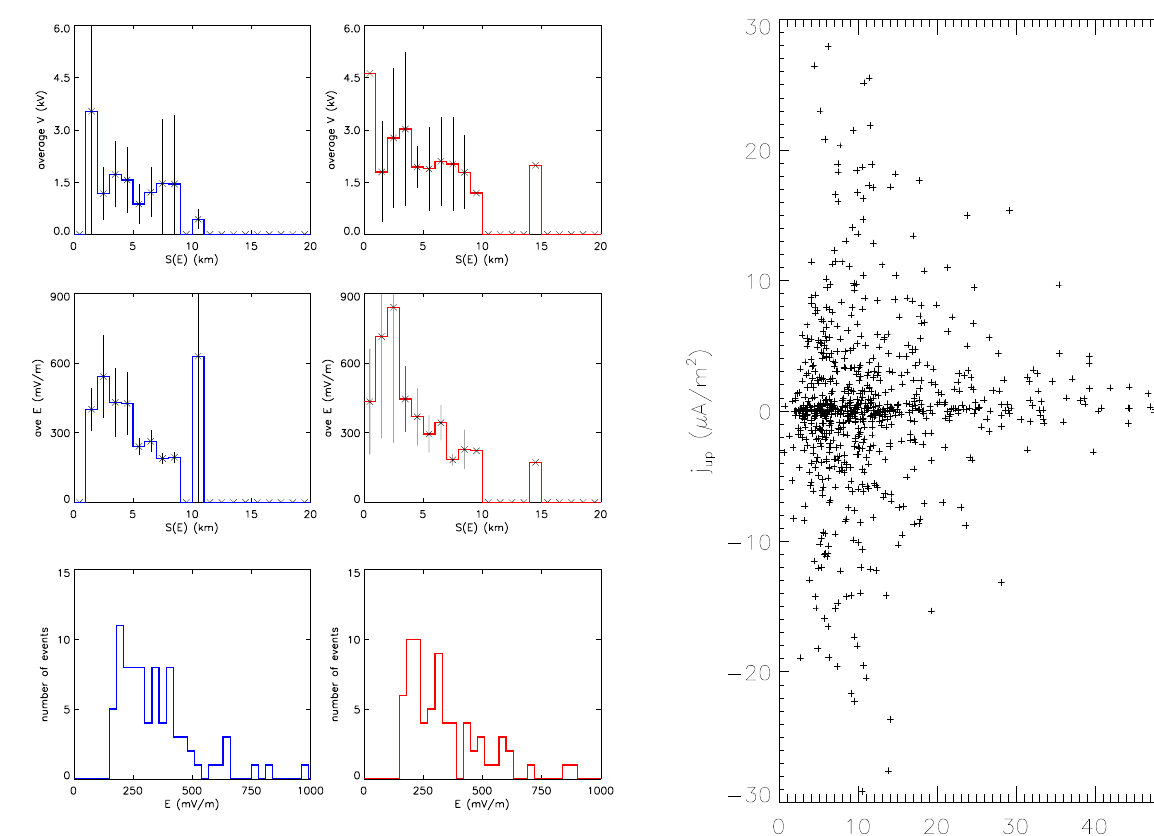
Fig. 7. Same as Figure 6, but this time only converging (red) and diverging (blue) bipolar events. The error bars indicate the 95.5% confidence interval. Fig. 8. Scatter plot of the FAC magnitude vs. FAC width, both mapped to the ionosphere. Positive values are upward